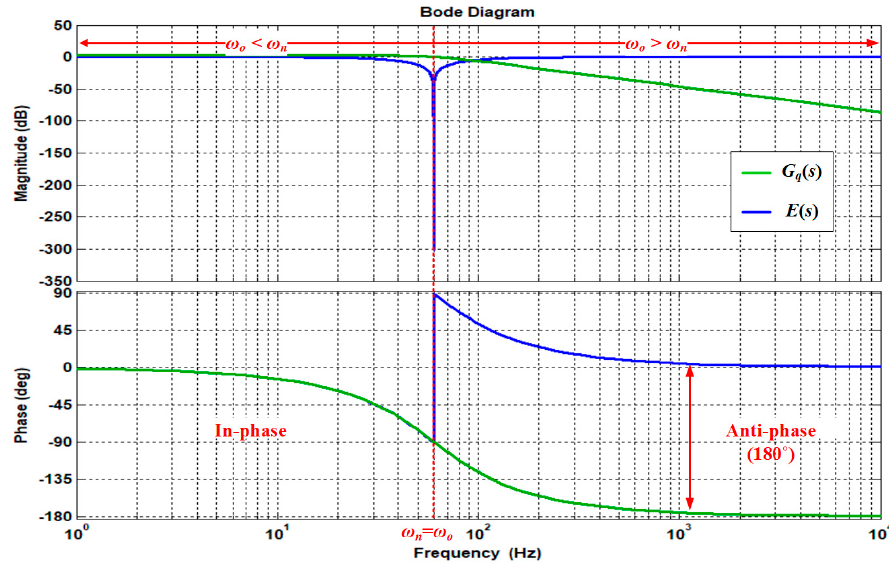
Figure 8. Bode diagram of SOGI-FLL.